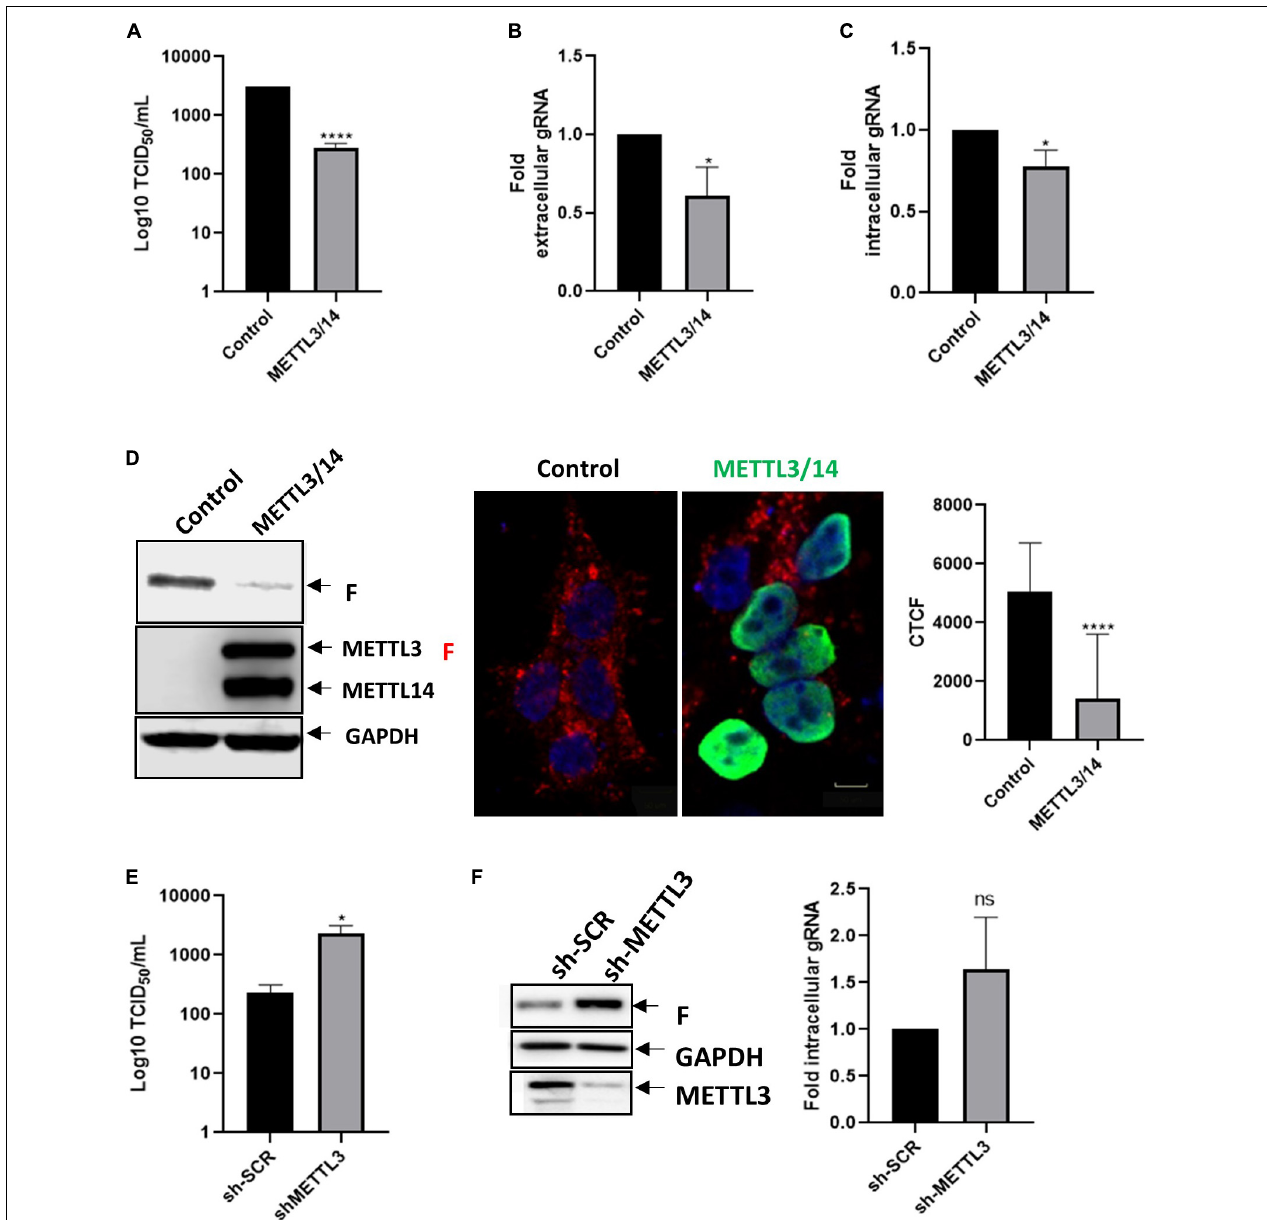
FIGURE 1 | METTL3/METTL14 complex regulates the replication and gRNA synthesis of HRSV. (A) HEK293T cells were transfected with vectors expressing Flag-tagged METTL3 and METTL14 or a control vector expressing d2EGFP. Then the cells were infected with HRSV at MOI:1 for 24 h. The supernatant was recovered, and the infectious titer was analyzed by the TCID 50 assay. (B) The extracellular and (C) intracellular gRNA was quantified by RT-qPCR. Results were normalized vs. the control (arbitrary set to 1) and expressed as the mean ± SD of three independent experiments. (D) Cell lysates from infected cells were used for the detection of the F protein and Flag-tagged proteins by Western blot. GAPDH was used as a loading control. The expression of F protein (red), METTL3/METTL14 complex (green) and nuclei (DAPI, blue) were analyzed by indirect immunofluorescence; representative fields are shown. Scale bar: 50 µ m. Corrected total cell fluorescence (CTCF) of F protein (red) from thirty cells was quantified using Image J. (E) Control and METTL3 knock down HEK293T cells were infected with HRSV at MOI:1 for 24 h, the supernatants were collected, and infectious titer was analyzed by the TCID50 assay. (F) The F protein was analyzed by Western blot and intracellular levels of the gRNA were quantified from control and METTL3 knock down cells. Results are representative of three independent experiments (* p < 0.05; **** p < 0.0001; ns, not